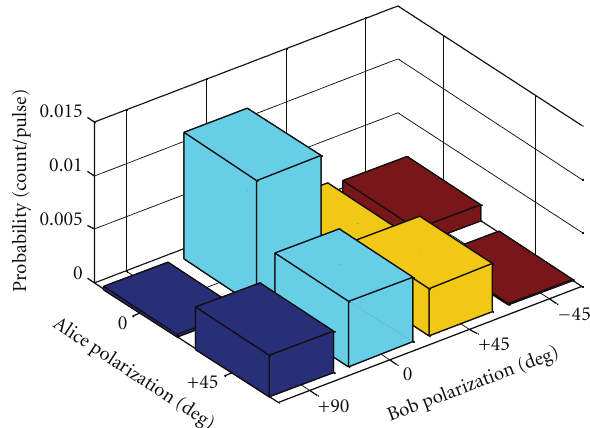
Figure 10: Rms angular jitter error of the polarization tracking system in the receiver as a function of commanded rotation angle of the half-wave plate in the polarization rotating simulator in front of the receiver.